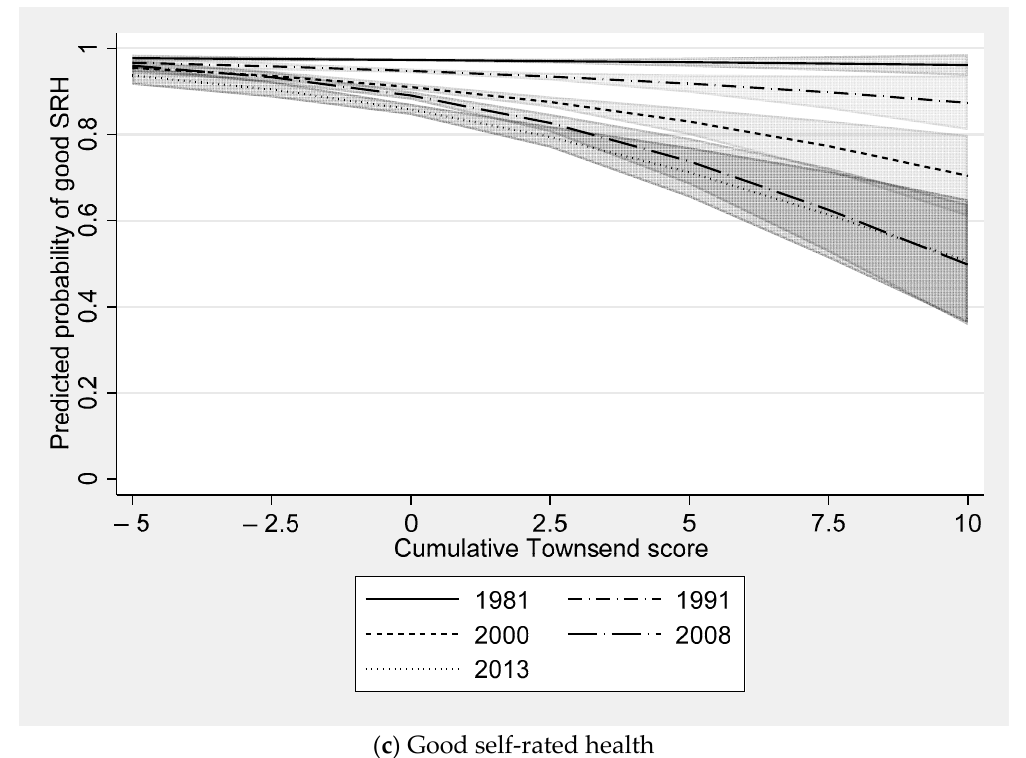
Figure 2. Predicted probability of self-rated health by survey year and cumulative Townsend score. Notes: shaded area around each line represents 95% confidence intervals.